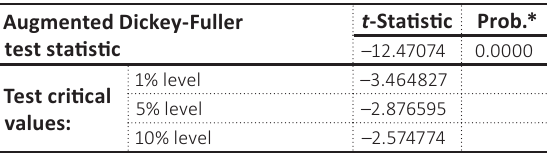
Table 1. Results of testing time series for stationarity in first differences